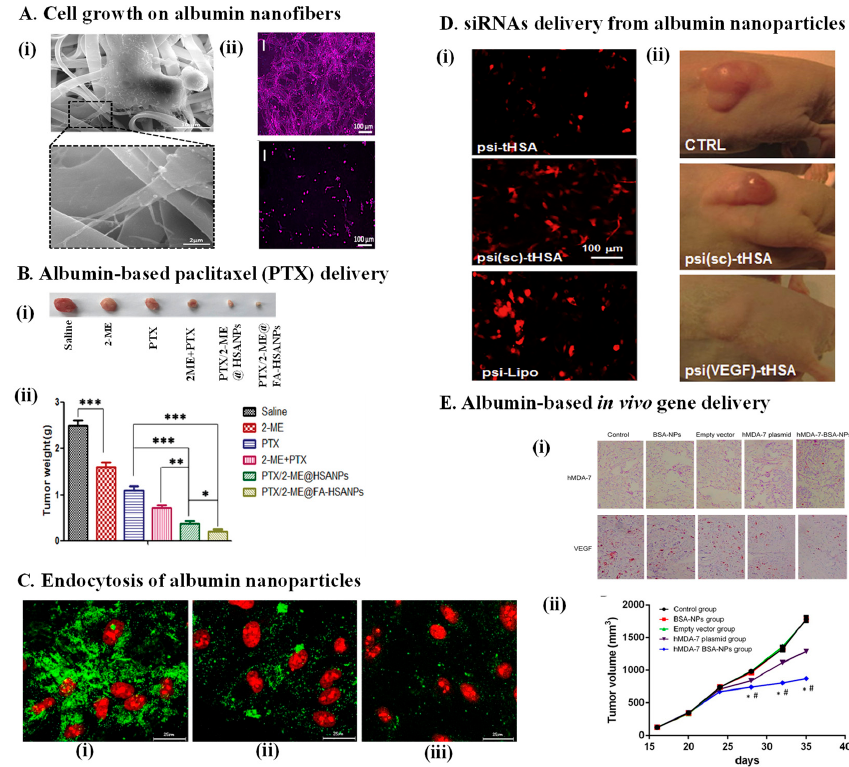
Figure 6. Applications of albumin scaffolds in regenerative medicine. ( A ). ( i ) SEM image of cardiomyocytes interaction with albumin fibers. ( ii ) Cultured cardiomyocytes on albumin fibers (top) and PCL fibers (bottom) (images taken from [58] with permission). ( B ). Improved paclitaxel (PTX) delivery using albumin nanoparticles. ( i ) the effect of treatments on tumor size after 13